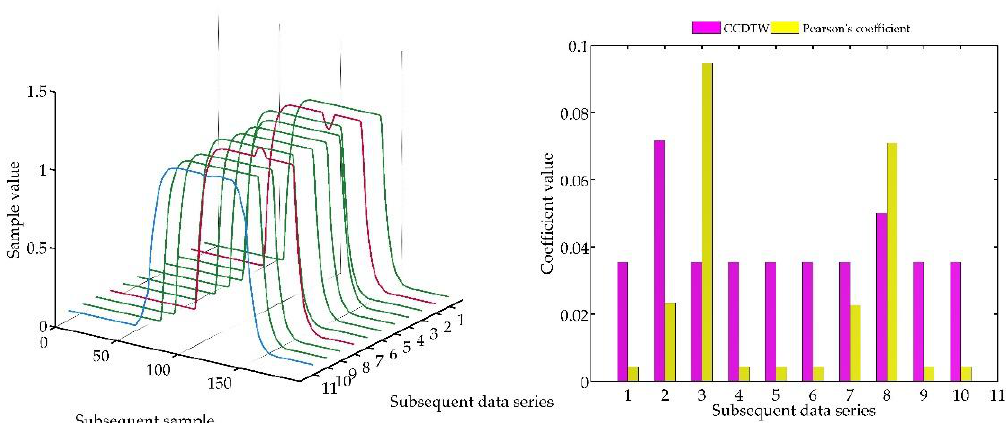
Figure 25. Simulation results obtained for shifted charts № 3 and № 7, and additionally disturbed № 2 and № 8 for r ampl = 1.